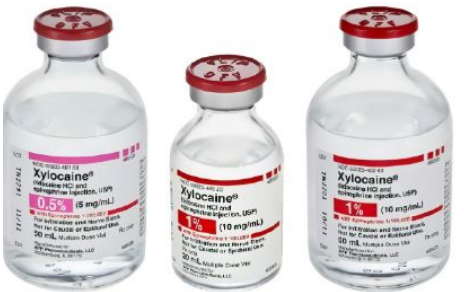
Figure 5. Xylocaine label, brand name of the drug lidocaine